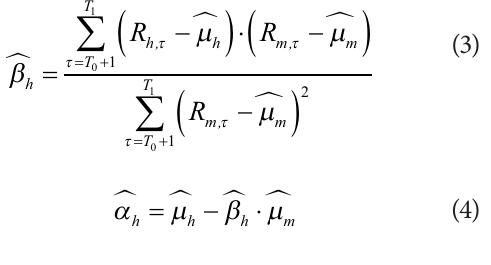
Figure 2. Event and estimation